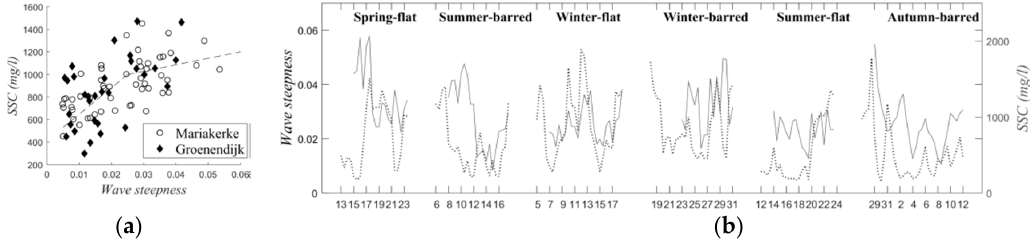
Figure 6. ( a ) Comparison between SSC and wave steepness when both are averaged over a tidal cycle. Data that were affected by the nearby sediment disposal during the Spring — flat campaign were removed. ( b ) Time series of SSC (gray line) and wave steepness (black, dotted line) for all campaigns.